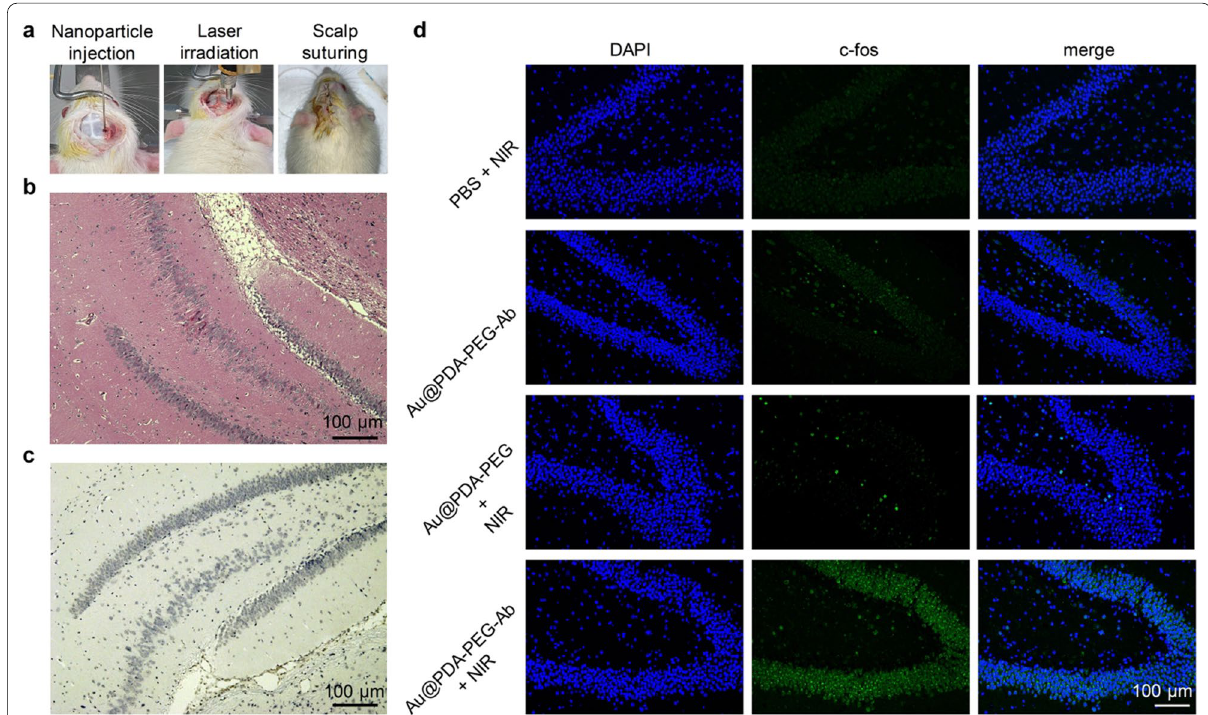
Fig. 6 In vivo NIR neural stimulation. a Procedures for in vivo neural stimulation. b H&E and c TUNEL staining of hippocampal slices after treated with Au@PDA-PEG-Ab and NIR-II laser irradiation. d C-fos staining of hippocampal slices after Au nanoparticles and NIR-II laser irradiation (1.0 W/cm 2